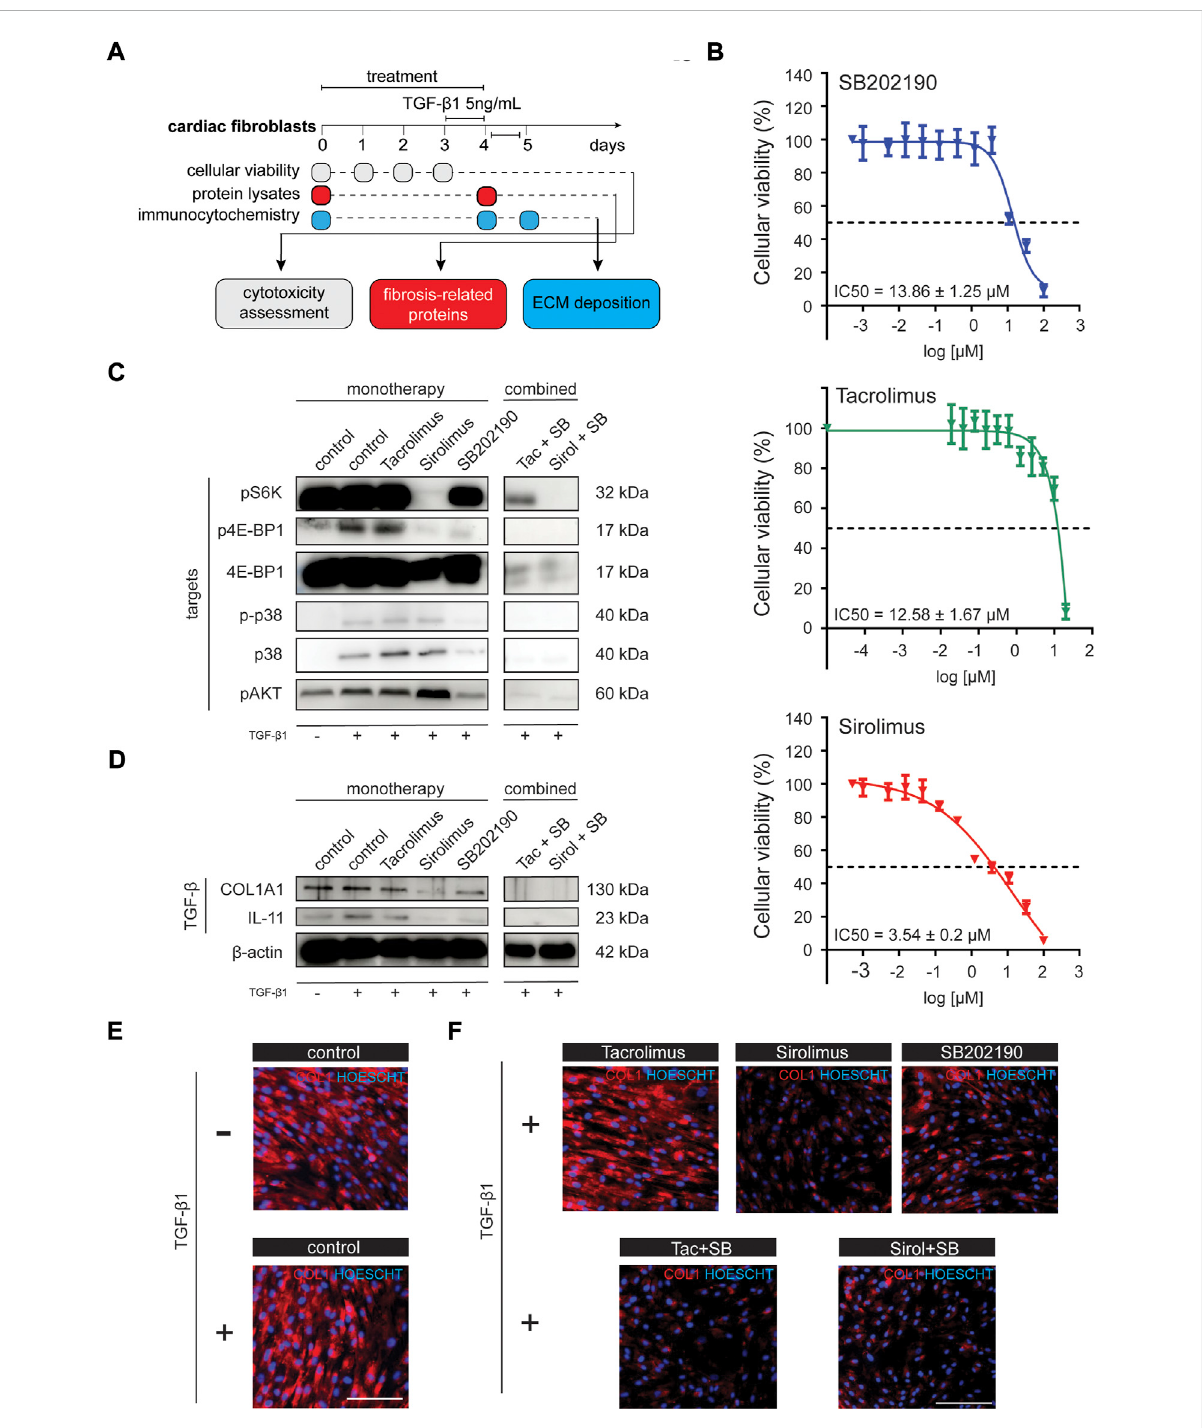
FIGURE 2 Chemical evaluation of anti fi brotic compounds in cardiac fi broblast primary human line activated with TGF- β 1. (A) Schematic representation of the experimental work fl ow. (B) IC50 assay (96 h) for the evaluation of the cytotoxic pro fi le of SB202190, Tacrolimus and Sirolimus in NHCF-V cell line. (C) Western blot analysis in NHCF-V cell line for pathway targets upon different treatments and TGF- β 1 stimulation [pS6K, p4E-BP1, 4E-BP1, p-p38,p38,pAkt; β -actinisusedas aloading controlderived fromthesameexperiments inFigure 3D]. (D) Western blotanalysis inNHCF-Vcell line for evaluation of cardiac fi brosis and TGF- β 1 responsive genes [COL1A1, IL-11]. (E) Immunocytochemistry analysis of COL1A1 expression in NHCF-V upon 5 ng/ml TGF- β 1 stimulation for 24 h. (F) Immunocytochemistry analysis of COL1A1 expression in NHCF-V treated with